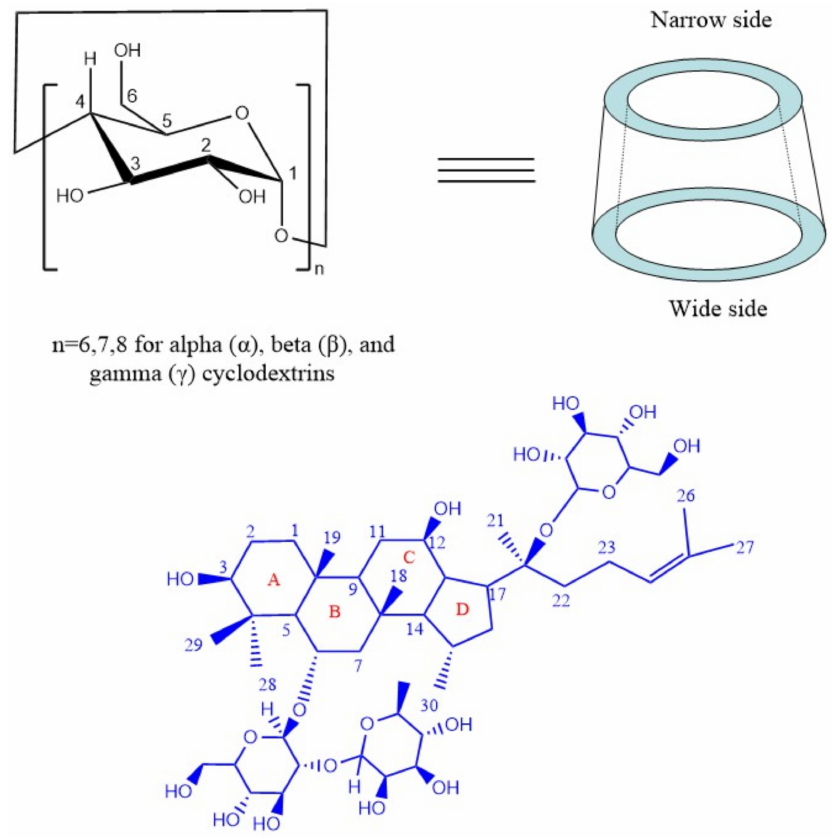
Figure 1. Structures of host ( α -CD, β -CD, γ -CD) and guest